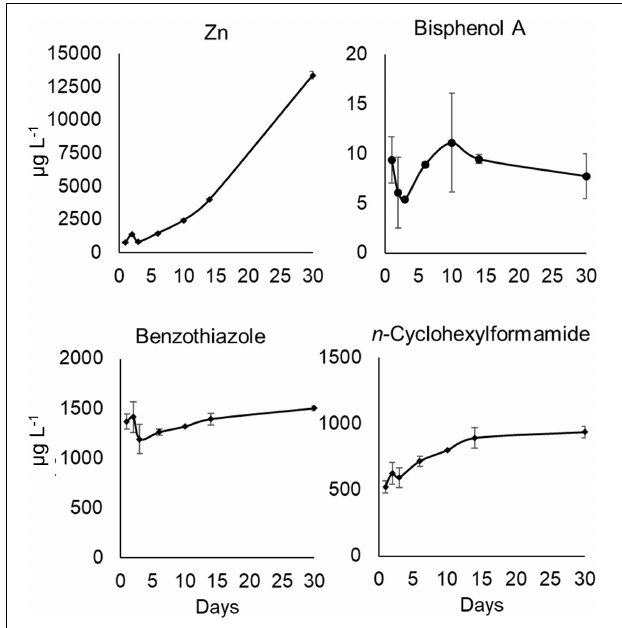
FIGURE 2 | Leaching of zinc, bisphenol A, benzothiazole and n-cyclohexylformamide from pristine crumb rubber granulate (RGS) into seawater over 30 days at a crumb rubber concentration of 100 g L − 1